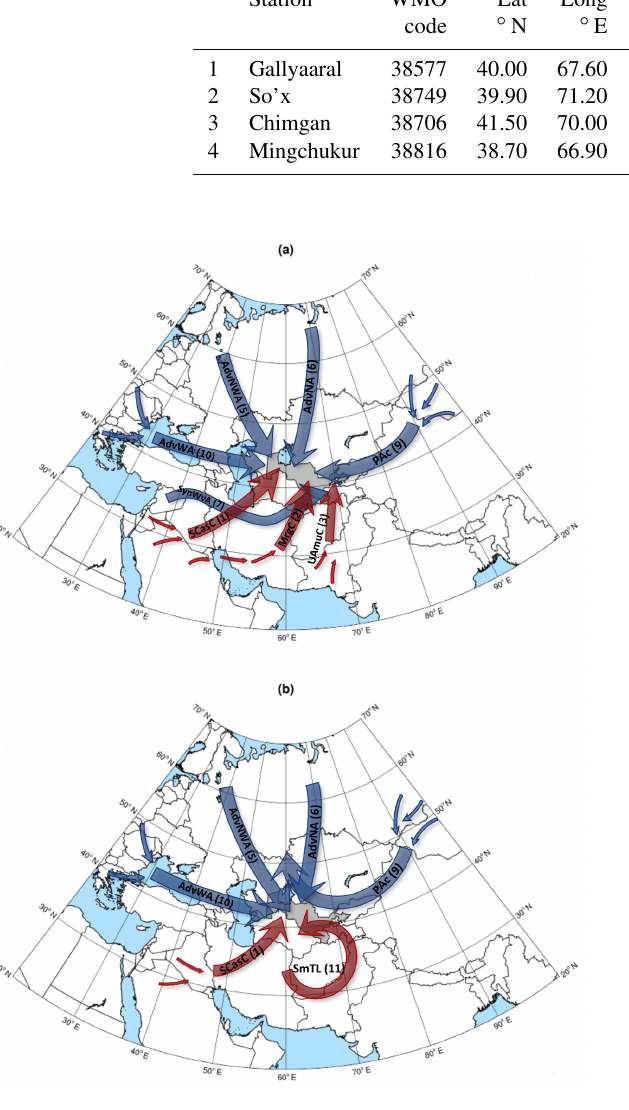
Figure 3. Scheme of synoptic weather types in central Asia and Uzbekistan during the cold (a) and warm seasons (b) of the year (after Inagamova et al., 2002). Blue and red arrows indicate rel- atively cold and warm air trajectories approaching the investiga- tion area (grey background). Abbreviations and numbers of each weather type are explained in Table